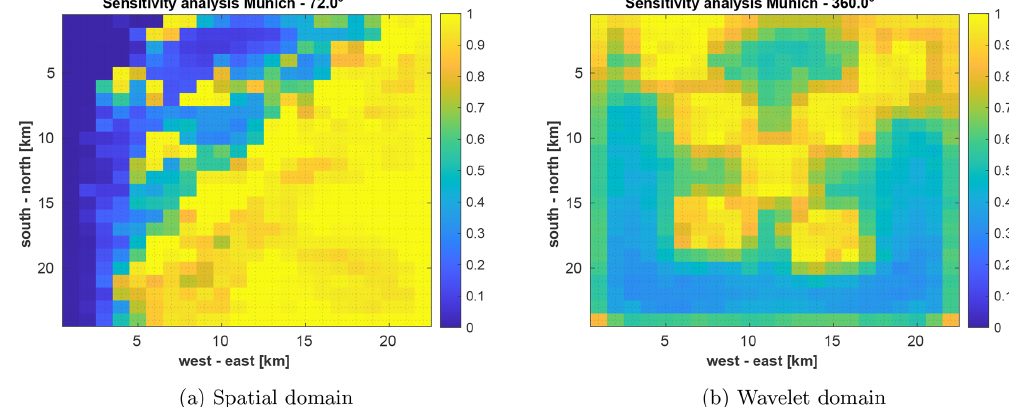
Figure F1. Sensitivity map of LS in Munich for a wind coverage of (a) 72 ◦ and (b) 360 ◦ . In (a) , the southeast has good sensitivity to the estimation, while the west and north of the city are only weakly sensitive. In (b) , there is no area which is not sensitive to the estimation, but the areas in the southeast are less